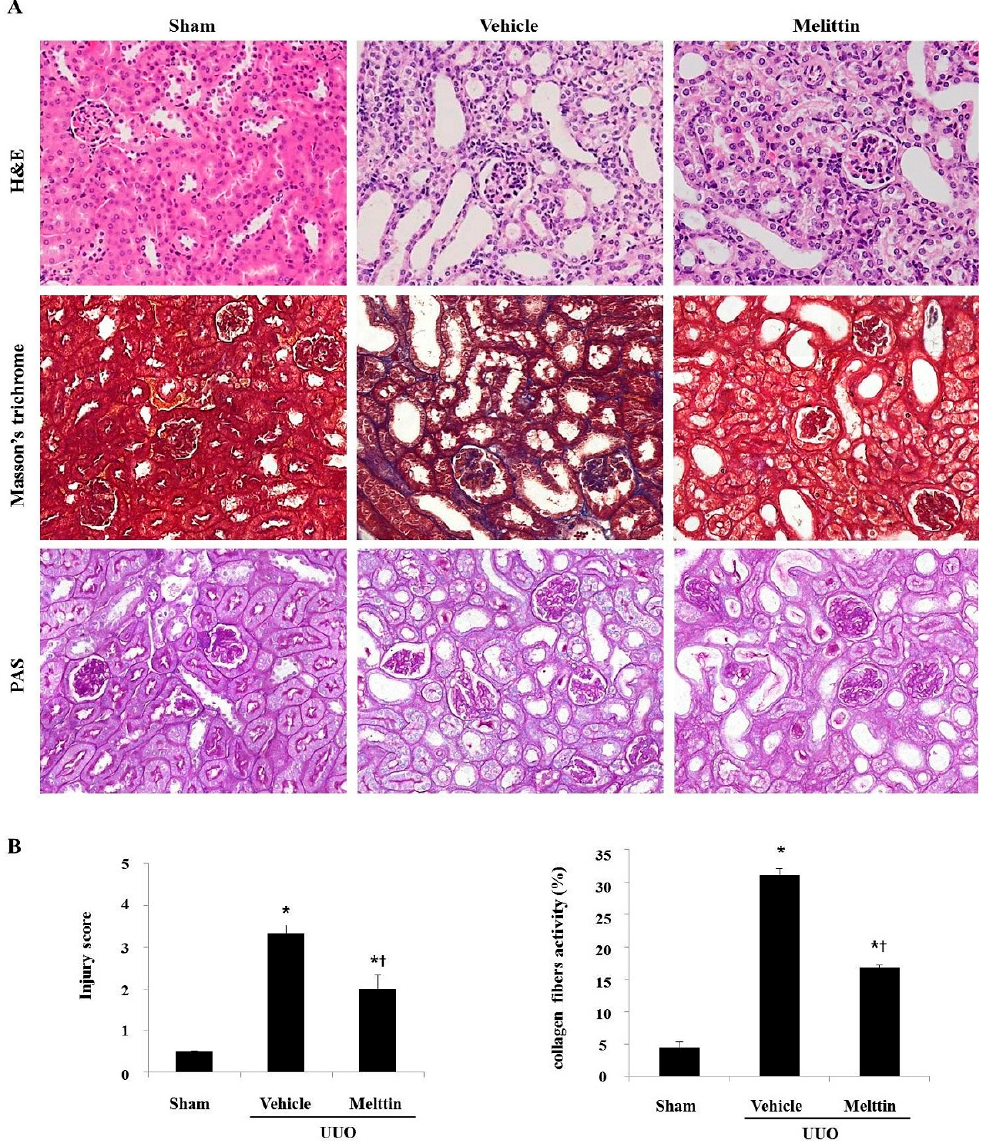
Figure 1. The effects of melittin on histological alterations in unilateral urethral obstruction (UUO) kidneys. Histopathological alterations in the hematoxylin and eosin (H&E) stained, the Masson’s trichrome-stained, and the periodic acid–Schiff (PAS) stained slides ( A ). The kidney sections are stained with Masson’s trichrome, which accentuates interstitial fibrosis by staining the collagen blue. ( B ) The semi-quantitative analysis of the interstitial injury score and relative fibrogenic area of the obstructed kidney in each group. These are representative images from each study group. Magnification 400 × . The results are expressed as means ± SE of three independent determinations. * p < 0.05 vs. Sham group. † p < 0.05 vs. Vehicle group.